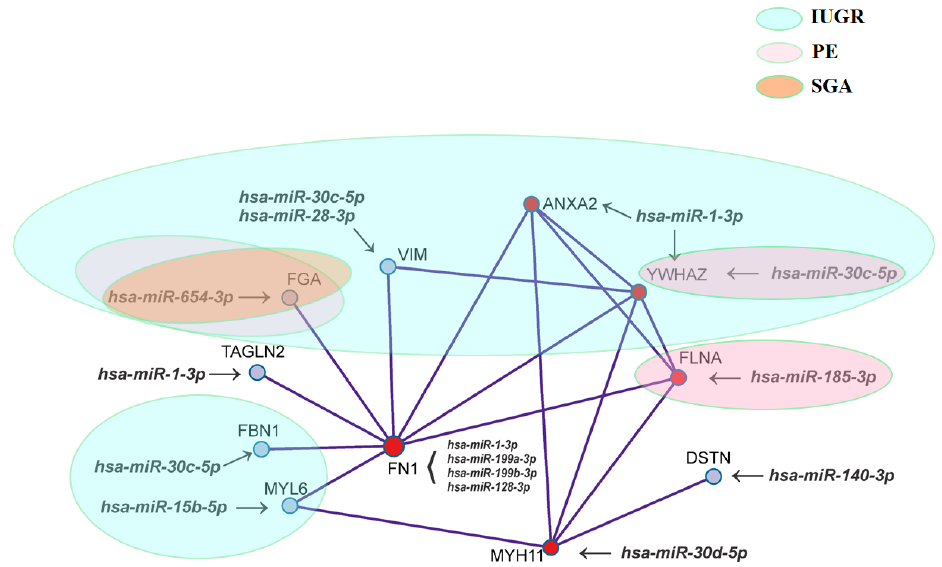
Figure 6. Network of proteins that form physical interactions with each other while applying the Molecular Complex Detection (MCODE) algorithm. Ovals of different colors contain miRNA‒gene target pairs, differentiating the IUGR, PE, and SGA groups from the control group.